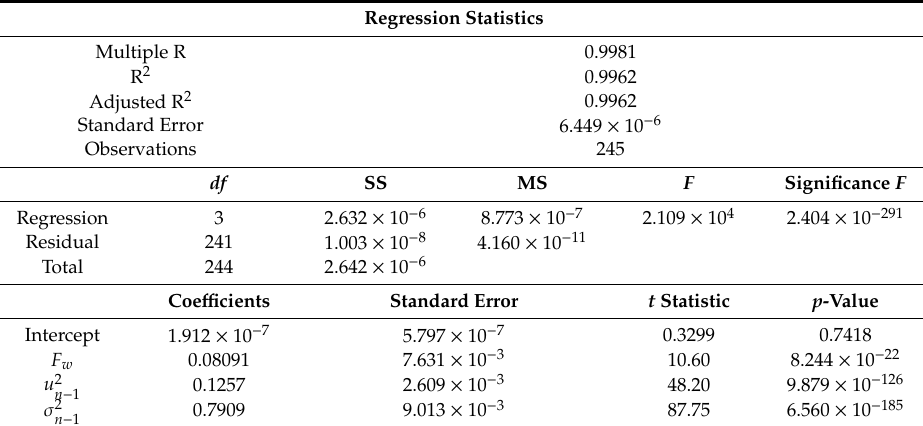
Table 6. Analysis of the S&P dataset.